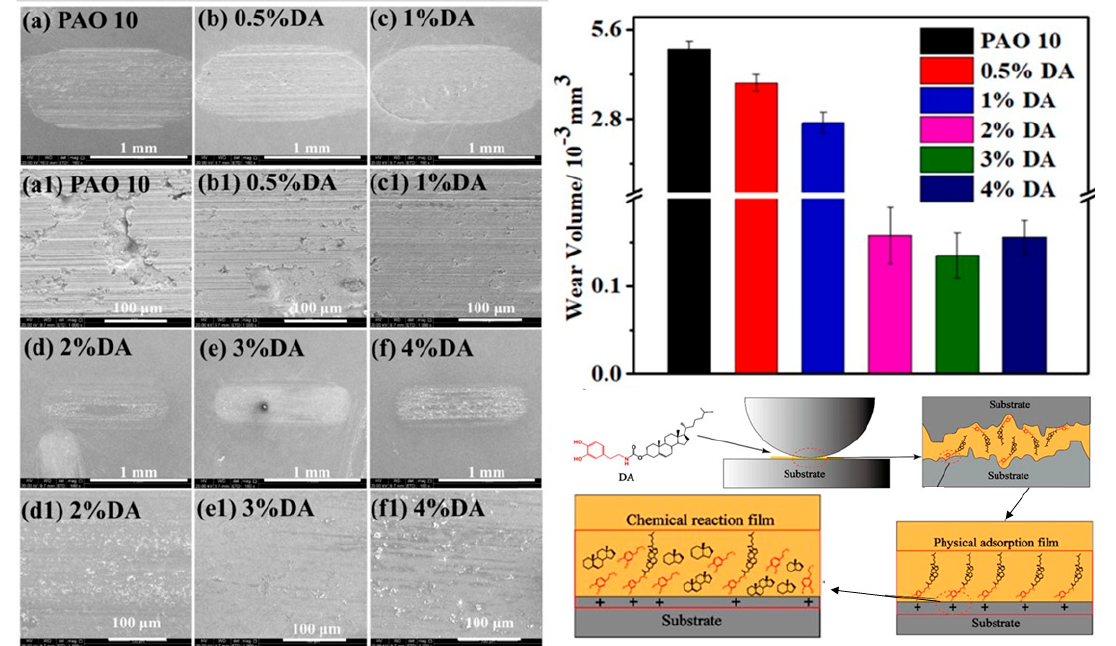
Figure 9. SEM morphology of wear-out sample with different compositions of DA in PAO 10 along with the critical value of wear rate. The 3% of DA in PAO 10 is the optimum/ideal value in terms of reduced friction and anti-wear surface [201]. Copyright permission from Elsevier, 2022.